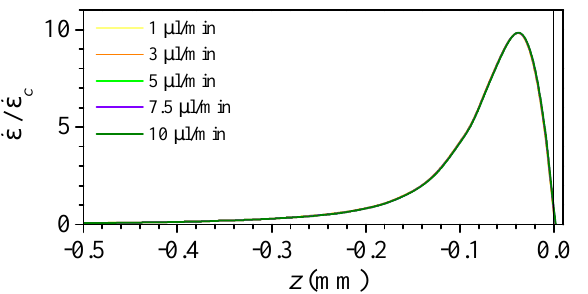
Figure 9. Dimensionless strain rate along the axis for nozzle 8 and different flow rates. The lines for all the flow rates overlap.